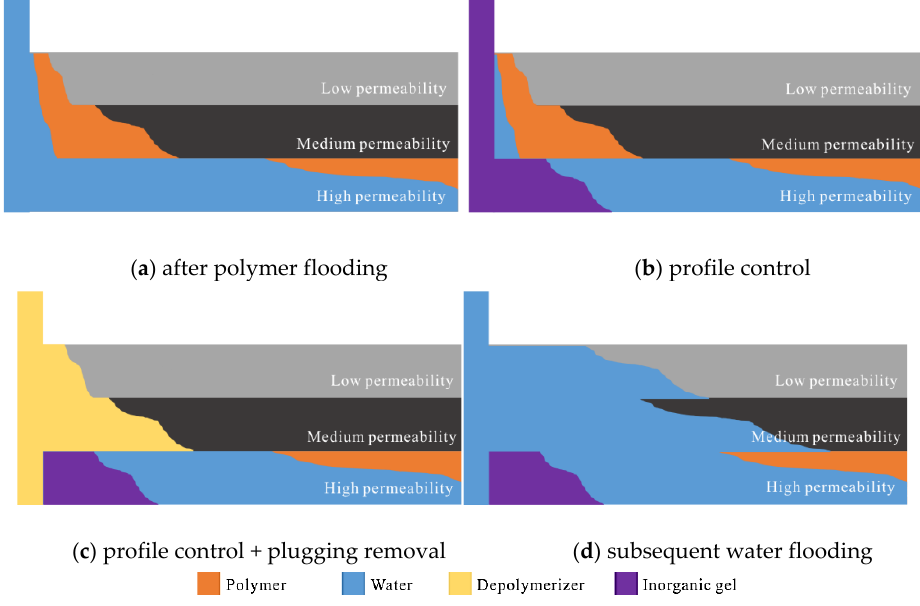
Figure 12. Action mechanism of “ profile control + plugging removal ” ( a ) after polymer flooding, ( b ) profile control, ( c ) profile control + plug removal and ( d ) subsequent water flooding.